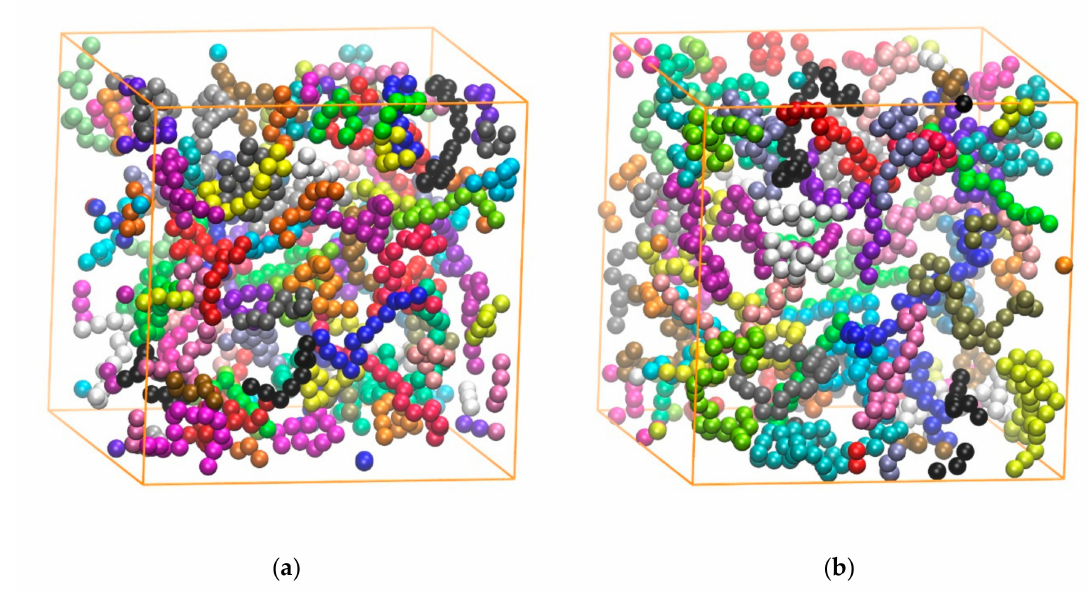
Figure A1. Snapshots of equilibrated packings of linear hard-sphere chains in the bulk at a packing density of 0.05, used as initial configurations for successive simulations with the square well potential. ( a ) 100 chains of N av = 12; ( b ) 50 chains of N av = 24. Spheres are colored according to the identity of the parent chain. Coordinates of sphere centers are subjected to periodic boundary conditions in all dimensions. Each figure panel is also available as stand-alone image in 3-D, interactive format in the Supplementary Materials.